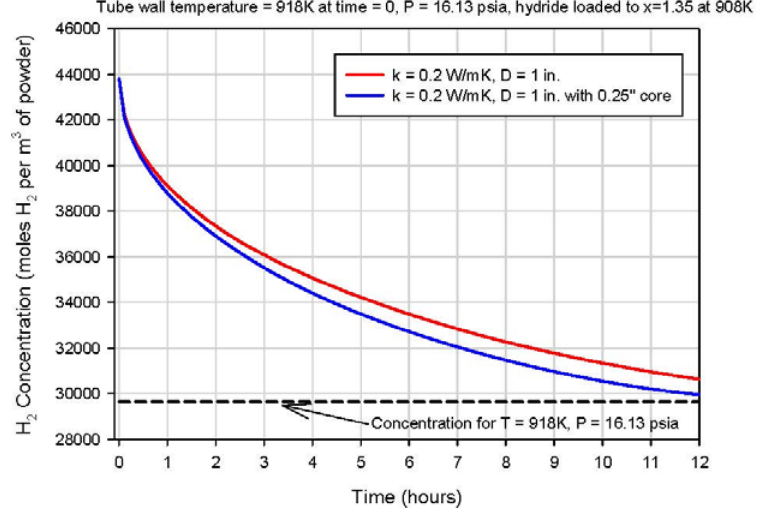
Figure 12. Modeled average hydrogen concentration in the hydride bed vs. time for a one-inch